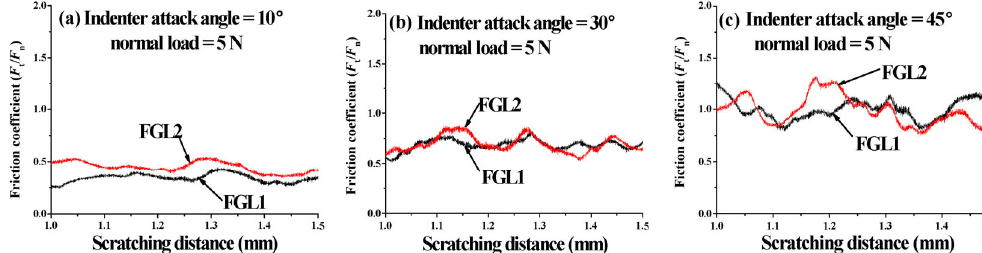
Fig. 10 Friction coefficient vs. scratching distance and indenter attack angle (normal load = 5